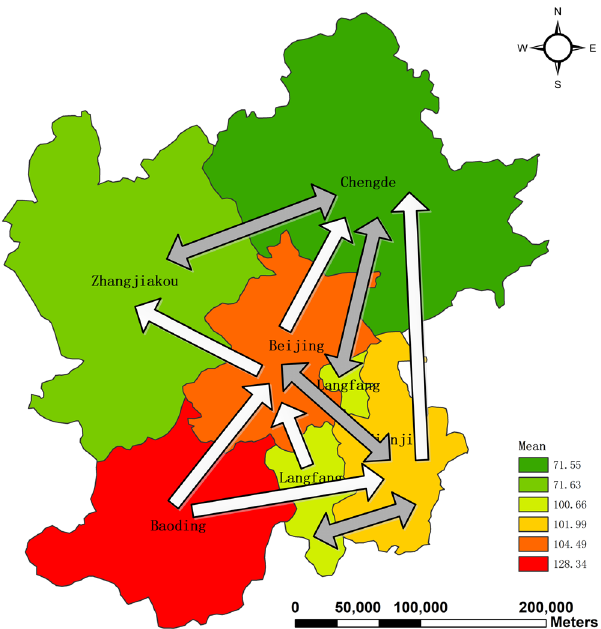
Figure 7. Causality relationships of air pollution between cities. The map was generated using ArcGIS (Version 10.3.1., https://www.arcgis.com). The source of the map is GADM database of Global Administrative Areas (http://www.gadm.org/). The study area is part of the map of